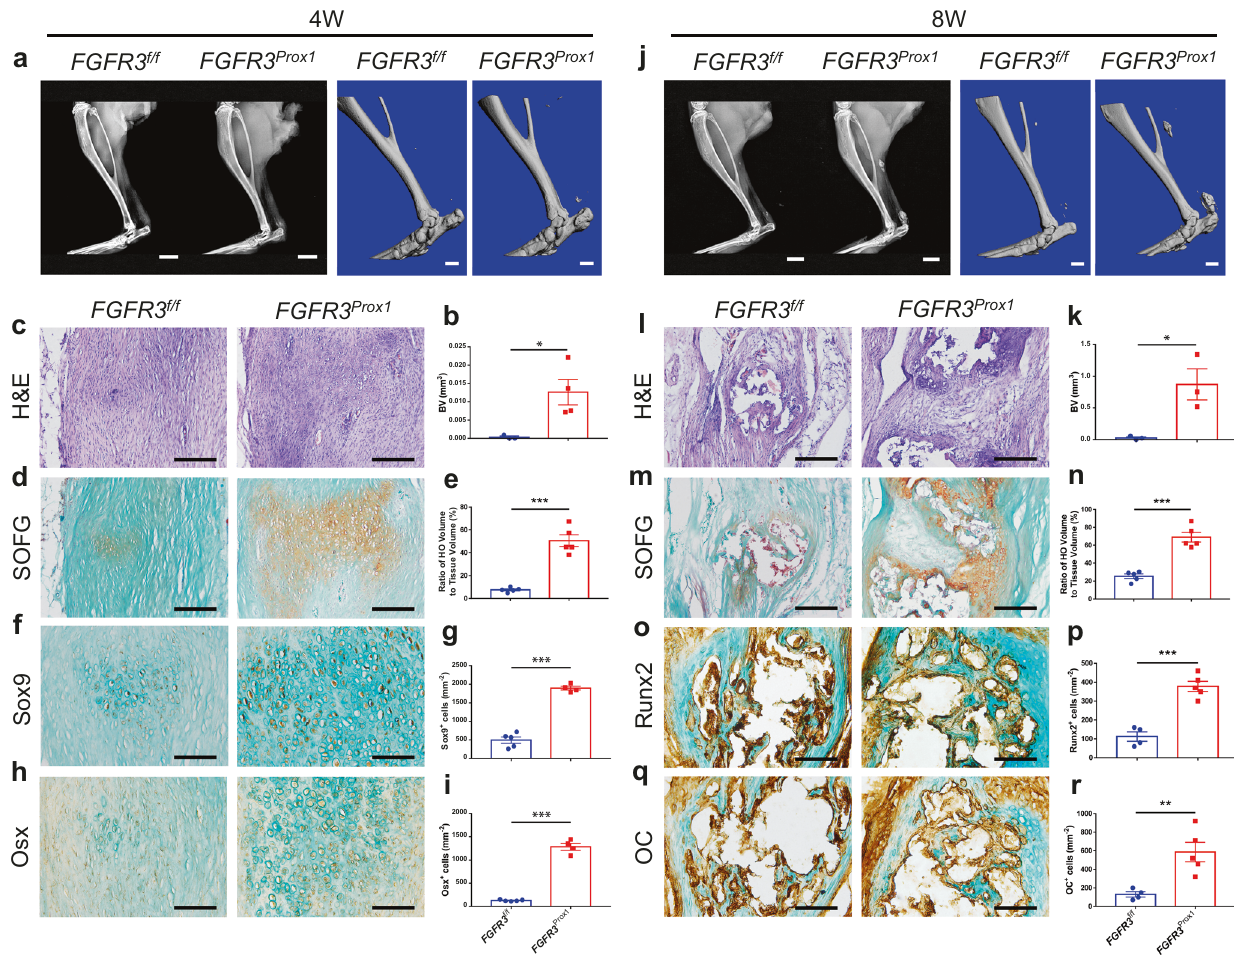
Fig. 3 FGFR3 deletion in LECs aggravates heterotopic bone formation. a , b Representative X-ray (left) and μ CT (right) images of heterotopic bone in the Achilles tendon and quantitative analysis in FGFR3 f/f ( n = 3) and FGFR3 Prox1 mice ( n = 4) at 4 weeks after tenotomy. Scale bars, 2 mm for X-ray; 1 mm for μ CT. c – e Representative H&E and SOFG images of heterotopic bone and histomorphometry analysis in FGFR3 f/f and FGFR3 Prox1 mice at 4 weeks after surgery. n = 5 per group. Scale bars, 200 μ m. f – i Representative immunohistochemical (IHC) staining of Sox9 ( f FGFR3 f/f = 5, FGFR3 Prox1 = 4) and Osx ( h FGFR3 f/f = 5, FGFR3 Prox1 = 4) and relative quantitative analysis ( g , i ). Scale bars, 100 μ m. j , k Representative X-ray (left) and μ CT (right) images of ectopic bone in the tendon and quantitative analysis ( k ) in FGFR3 f/f ( n = 3) and FGFR3 Prox1 mice ( n = 3) at 8 weeks after Achilles tenotomy. Scale bars, 2 mm for X- ray; 1 mm for μ CT. l – n Representative H&E and SOFG images of ectopic bone and histomorphometry analysis in FGFR3 f/f and FGFR3 Prox1 mice at 8 weeks after tenotomy. n = 5 per group. Scale bars, 200 μ m. o – r Representative immunohistochemical staining of Runx2 ( o FGFR3 f/f = 4, FGFR3 Prox1 = 5) and OC ( q FGFR3 f/f = 4, FGFR3 Prox1 = 5) and relative quantitative analysis ( p , r ). Scale bars, 100 μ m. All data represent mean ± SEM. * P < 0.05; ** P < 0.01; *** P < 0.001 by unpaired two-tailed Student ’ s t tendon by upregulating BMPR1a-pSmad1/5 signaling in LECs, (Supplementary Fig. 7g-j). Taken together, our data from mice we examined the expressions of BMPR1a and pSmad1/5 in the and human samples suggest that FGFR3 is essential for the local tendon of Col2 tomato and FGFR3 f/f -Col2 tomato mice at 8 weeks lymphatic formation during post-traumatic HO formation and post surgery. Immunostaining revealed that FGFR3 expression in downregulated FGFR3 expression of LECs in the in fl ammatory tdTomato-labeled LYVE1 + LECs was signi fi cantly decreased in milieu during HO progression leads to decreased lymphatic the repaired tendon of FGFR3 f/f -Col2 tomato mice (11.4 ± 3.0%) formation, which further aggravates in fl ammation levels promot- compared with controls (77.4 ± 5.6%) 8 weeks post tenotomy ing HO development. (Fig. 5a, b). Co-immunostaining of LYVE1 and BMPR1a revealed that tdTomato-labeled Col2 + cells adopted LEC fate with 9.0 ± 0.7% BMPR1a expression in repaired Achilles tendons of Col2- tomato mice. By contrast, signi fi cantly increased BMPR1a expression (40.1 ± 5.4%) was observed in tdTomato-labeled LYVE1 + LECs in the tendon of FGFR3 f/f -Col2 tomato mice (Fig. 5c, d). Similar results were found by co-immunostaining of LYVE1 and pSmad1/5. The expressions of pSmad1/5 in tdTomato-labeled LYVE1 + LECs were signi fi cantly increased in FGFR3 f/f -Col2 tomato mice (48.4 ± 5.6%) relative to Col2 tomato mice (10.6 ± 1.8%) (Fig. 5e, f). Furthermore, FGFR3 knockdown in a bits lymphatic formation in the traumatically injured Achilles